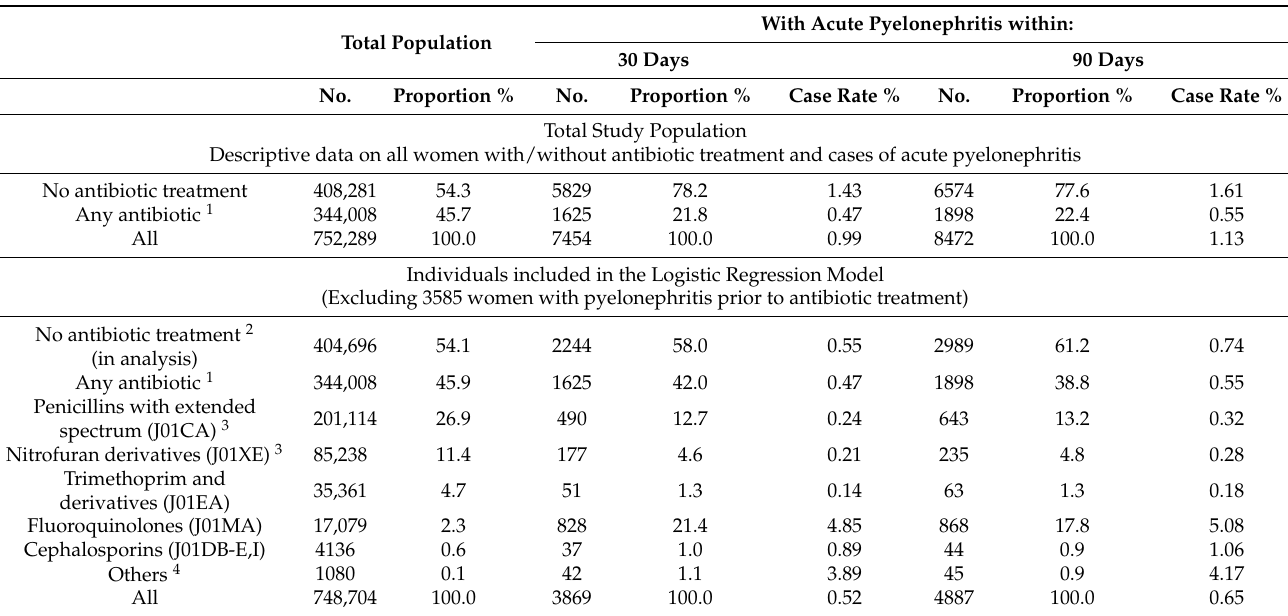
Supplementary Table S1 includes all descriptive data on the study population. 1 Redeemed antibiotic prescription within five days from the cystitis event and before the pyelonephritis event; 2 3585 women were excluded due to diagnosis of outcomes before antibiotic treatment; 3 more or less only pivmecillinam and nitrofurantoin; 4 others included ATC codes J01MB, J01EB, J01EC, J01ED, J01EE, and J01CR. Nationwide primary healthcare data were